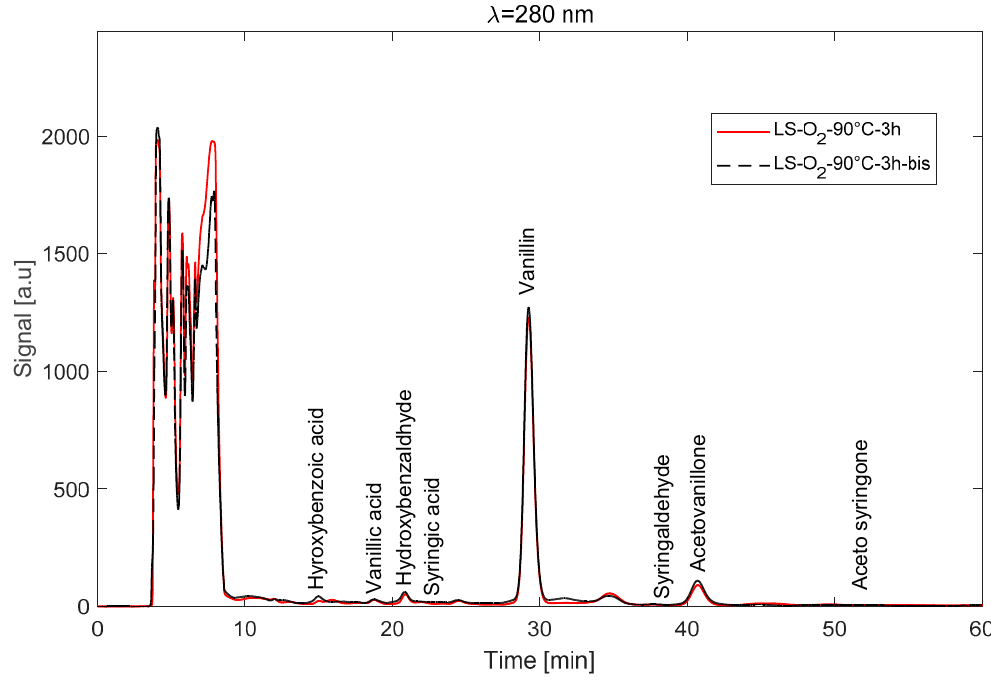
Figure 2. Example of a RP–HPLC chromatogram (90 °C–O 2 –3 h).